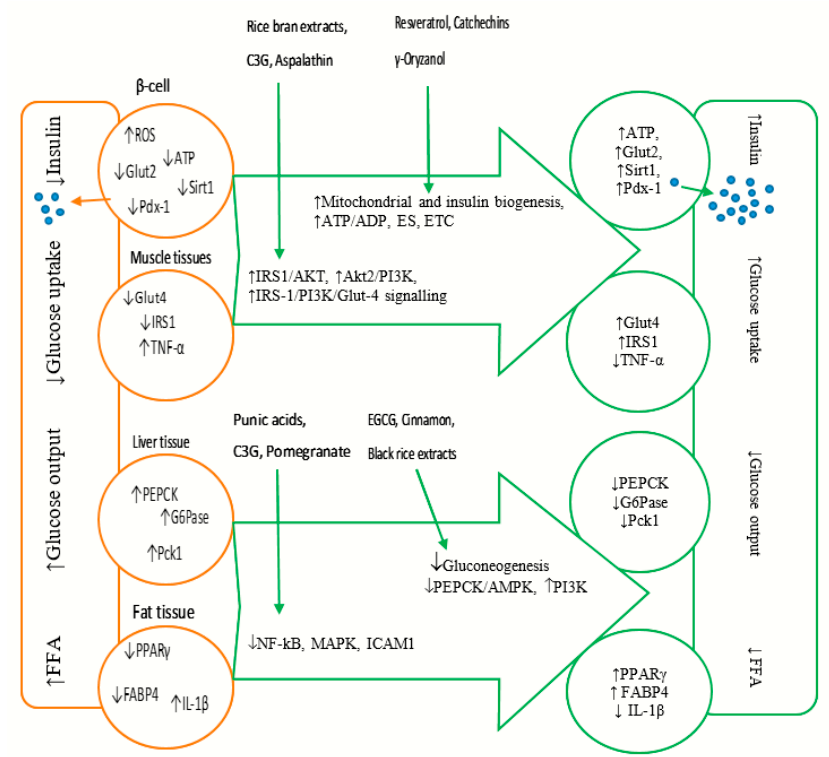
Figure 2. Schematic summary of how various plant-derived phenolic compounds target signalling pathways on various cell types and tissues in type 2 diabetes mellitus. ROS – reactive oxygen species; pathways on various cell types and tissues in type 2 diabetes mellitus. ROS—reactive oxygen ATP - Adenosine triphosphate; Glut2 - glucose transporter 2; Glut4 – glucose transporter 4; Sirt1 - species; ATP—Adenosine triphosphate; Glut2—glucose transporter 2; Glut4—glucose transporter Sirtuin 1; Pdx-1 – pancreas and duodenal homeobox 1; IRS1 – insulin receptor substrate 1; TNF- α - 4; Sirt1—Sirtuin 1; Pdx-1—pancreas and duodenal homeobox 1; IRS1—insulin receptor substrate 1; tumour necrosis factor alpha; ADP - Adenosine diphosphate; ES – endoplasmic reticulum stress; AKT - Protein kinase B; PI3K - Phosphatidylinositol 3-kinase; PEPCK - Phosphoenolpyruvate TNF- α —tumour necrosis factor alpha; ADP—Adenosine diphosphate; ES—endoplasmic reticulum carboxykinase; G6Pase - Glucose-6-phosphatase; PcK1 – Phosphoenolpyruvate carboxykinase 1; PPAR γ - peroxisome proliferator-activated receptor; FABP4 - fatty acid binding protein 4; IL-1 β - Interleukin 1 β ; NF-kB - Nuclear factor kappa light chain enhancer of activated B cells; MAPK - mitogen activated protein kinase; ICAM1 - intracellular adhesion molecules-1; C3G - Cyanidin 3- glucoside; EGCG - Epigallocatechin gallate; black arrows: ↑ - increased gene expression and ↓ - decreased gene expression); orange arrow – decreased insulin secretion under hyperglycaemic MAPK—mitogenactivatedproteinkinase; ICAM1—intracellularadhesionmolecules-1; C3G—Cyanidin condition; short green arrow - increased insulin secretion after polyphenols treatment; long green arrows – different polyphenol extracts and phenolic compounds targeting various pathways. 3-glucoside; EGCG—Epigallocatechin gallate; black arrows: ↑ —increased gene expression and ↓ —decreased gene expression); orange arrow—decreased insulin secretion under hyperglycaemic condition; short green arrow—increased insulin secretion after polyphenols treatment; long green arrows—di ff erent polyphenol extracts and phenolic compounds targeting various